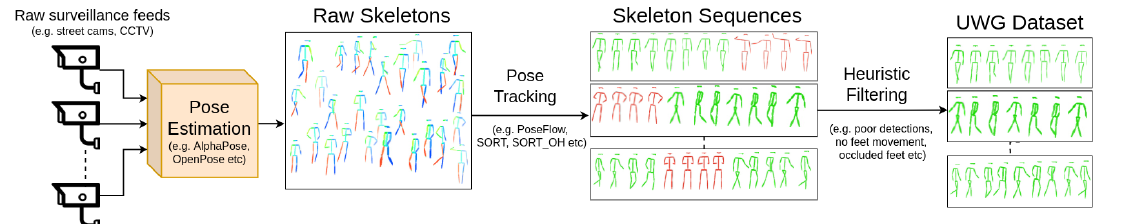
Figure 2. Data collection procedure. We process raw video streams from real-world settings of people walking and construct Unconstrained Wild Gait (UWG), a dataset of skeleton sequences loosely annotated through pose estimation and pose tracking. We use this raw and noisy data to pretrain a gait recognition model that generalizes well to different gait recognition scenarios. Skeletons are extracted from raw surveillance feeds with a well known multi-person pose estimation model, AlphaPose [8], which are then tracked intra-camera with a pose tracking model (SORT [40]). Finally, sub-par skeleton sequences are removed with simple heuristics. Best viewed in